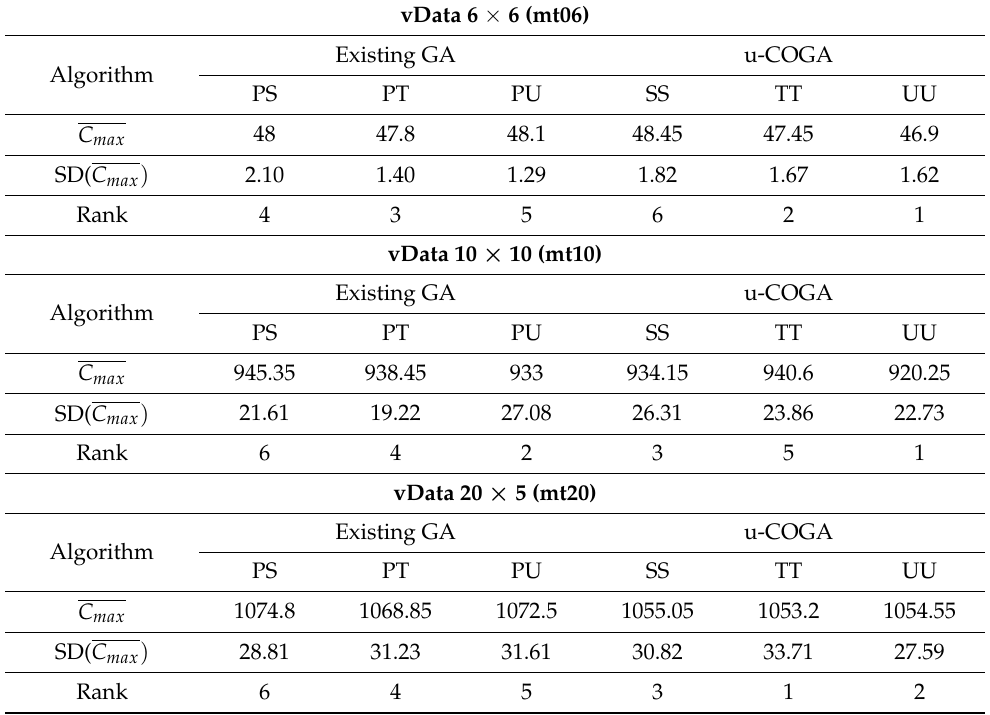
Table 8. Experiment results for vData.